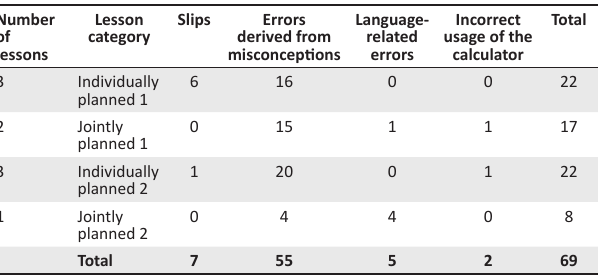
TABLE 2: Types of errors that occurred per lesson